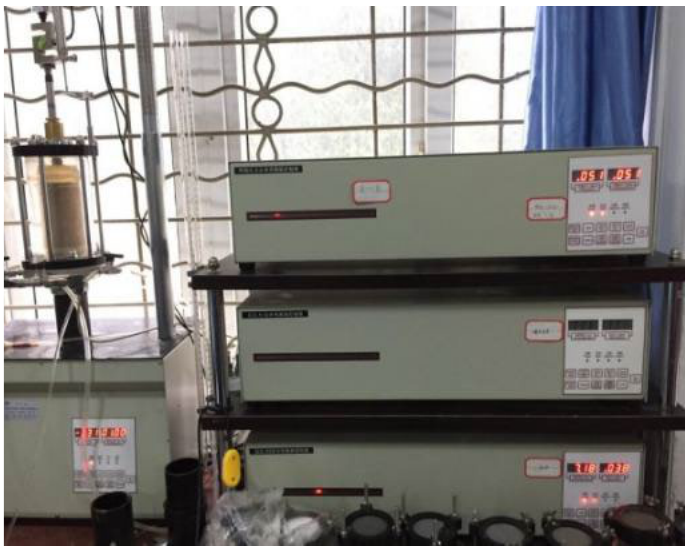
Figure 7. Test system of the triaxial shear apparatus.